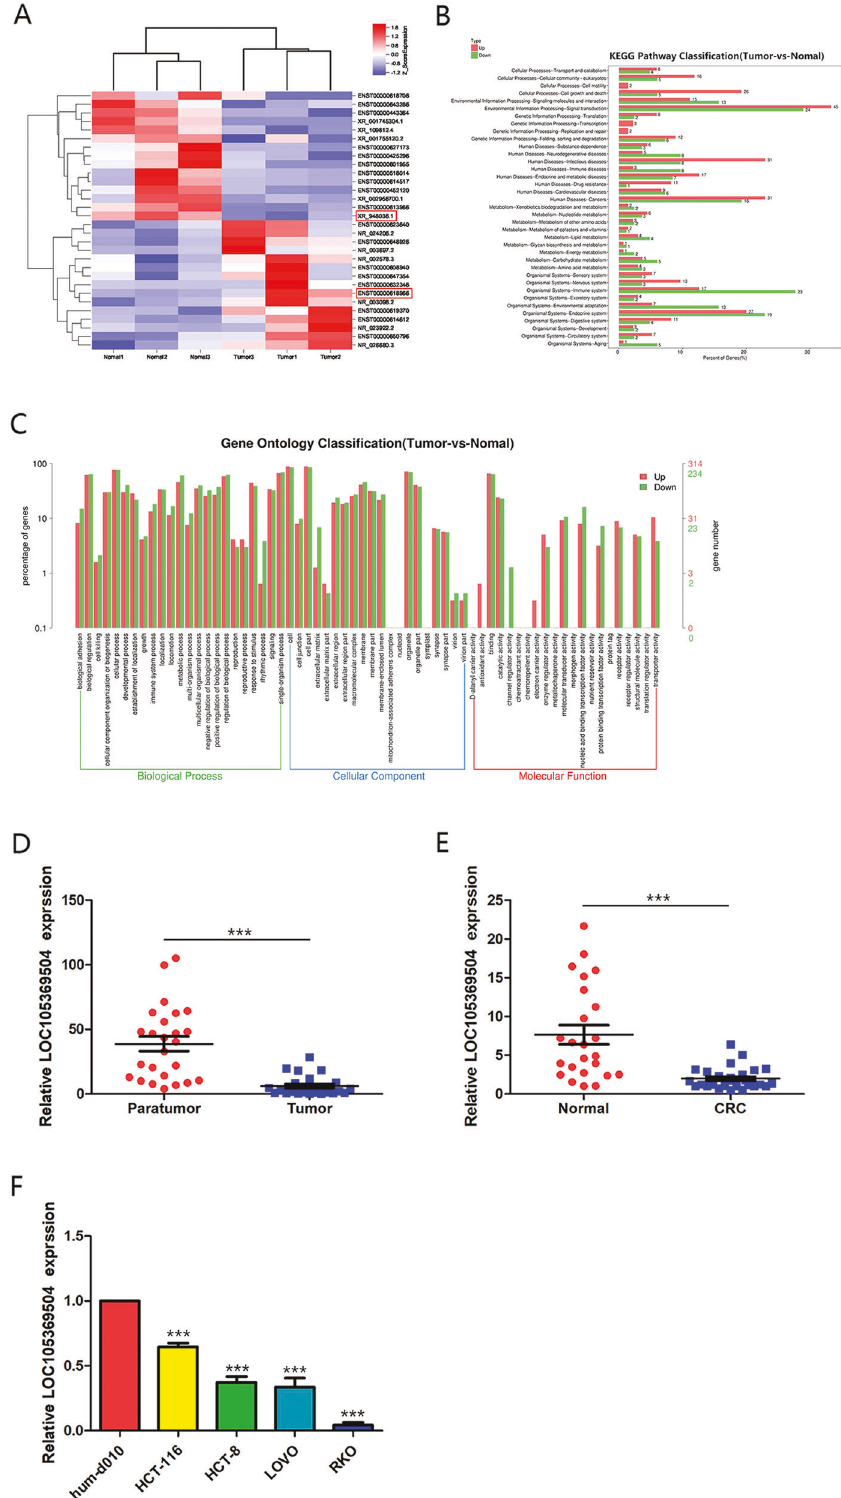
Fig. 1 Differential lncRNA expression pro fi le and LOC105369504 is downregulated in CRC. A Heat map of the top 30 differentially expressed lncRNAs between CRC and paracancerous tissues. B KEGG enrichments of the top 30 DEGs. C GO enrichments of the top 30 DEGs. D Expression of LOC105369504 was decreased in CRC tissues compared to paracancerous tissues. E LOC105369504 expression was reduced in plasma of patients with CRC compared to normal controls. F Expression of LOC105369504 was attenuated in CRC cells compared to normal colorectal epithelial cells. All data are described as the mean ± SD. *** p < 0.001.